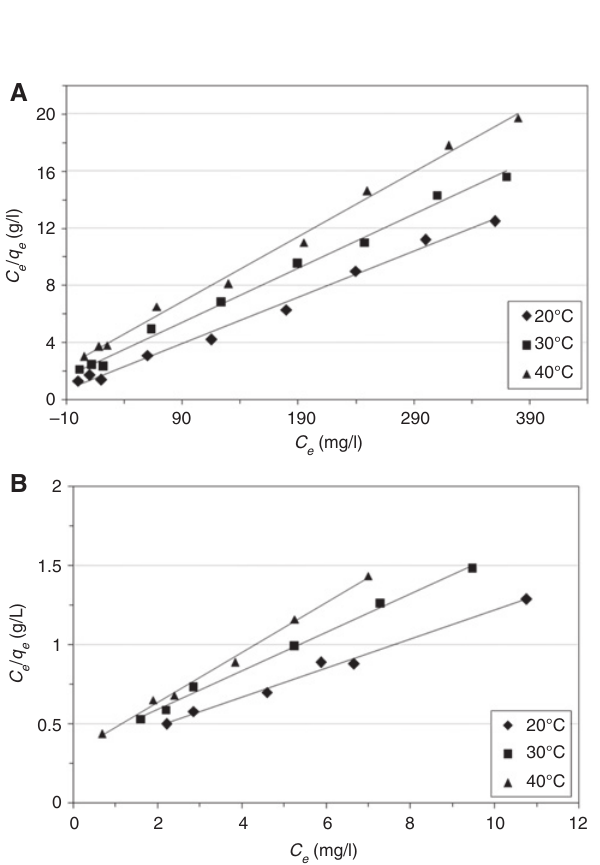
Figure 8: Langmuir isotherm plots for Mn-doped laterite: (A) phosphate, (B) fluoride.